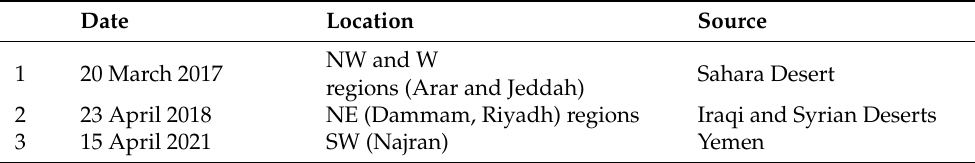
Table 1. Major dust events blown over Saudi Arabia in 2017, 2018, and 2021. Source: